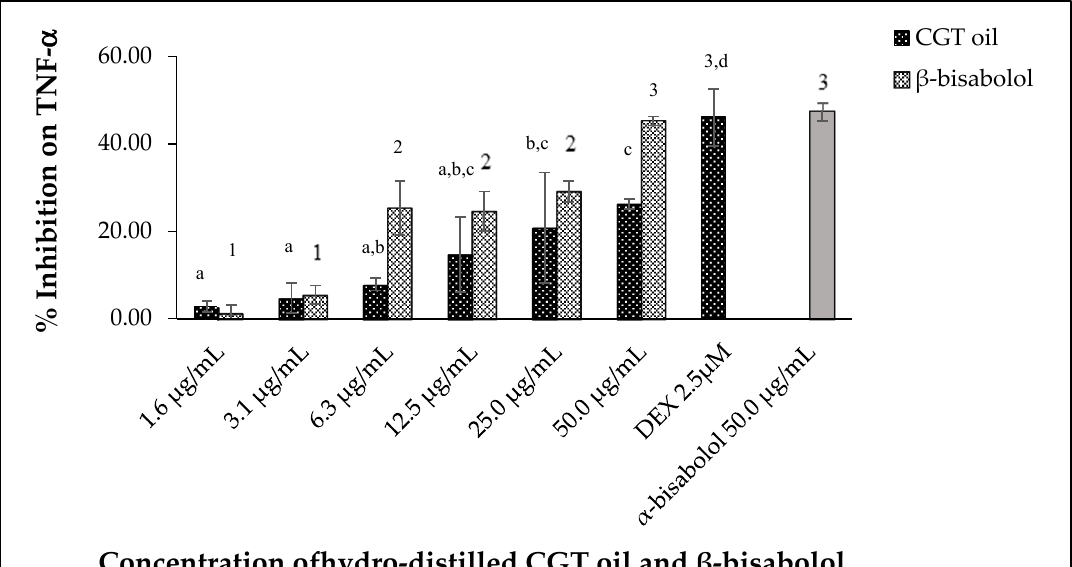
Figure 8. Effect of CGT oil and β -bisabolol dilutions on TNF- α production in RAW 264.7 cells . RAW 264.7 cells were exposed to test extracts or compounds for 1 h and then induced with 100 ng/mL lipopolysaccharide (LPS) for TNF- α production ( n = 3). Values are expressed as mean ± SD. Duncan’s multiple range test between average TNF- α production across the different concentrations indicates dissimilar letters/numerals denote a significant difference ( p ≤ 0.05). 2.6. Comparing Effect of β -Bisabolol and α -Bisabolol on Two Inflammation Mediators Produced by RAW264.7 Cells